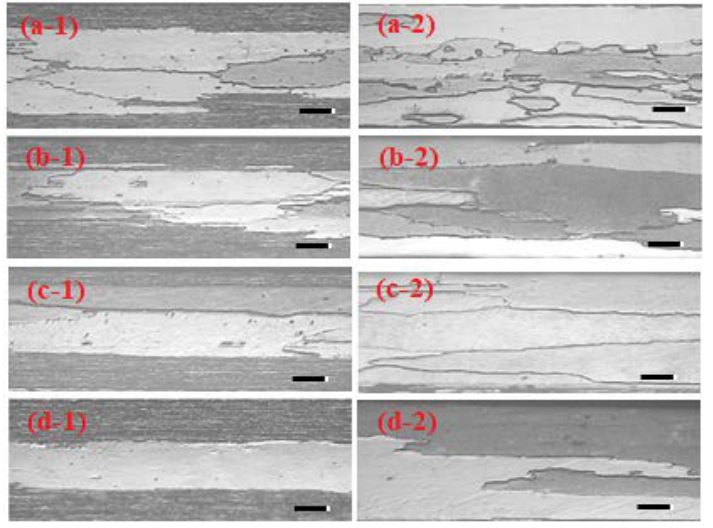
Figure 4. Microstructure evolutions during the recrystallization process of samples ( a ) 1#-0, ( b ) 1#-1, ( c ) 2#-0, and ( d ) 2#-1. Suffixes -1 and -2 mean recrystallization start and end, respectively. Bars are 100 μm.